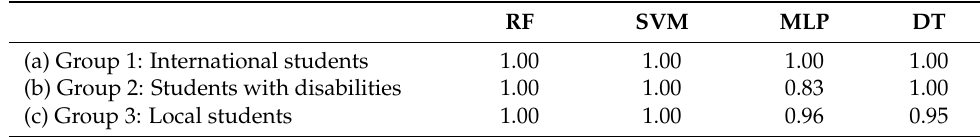
Table 6. AUC results of Case 3.